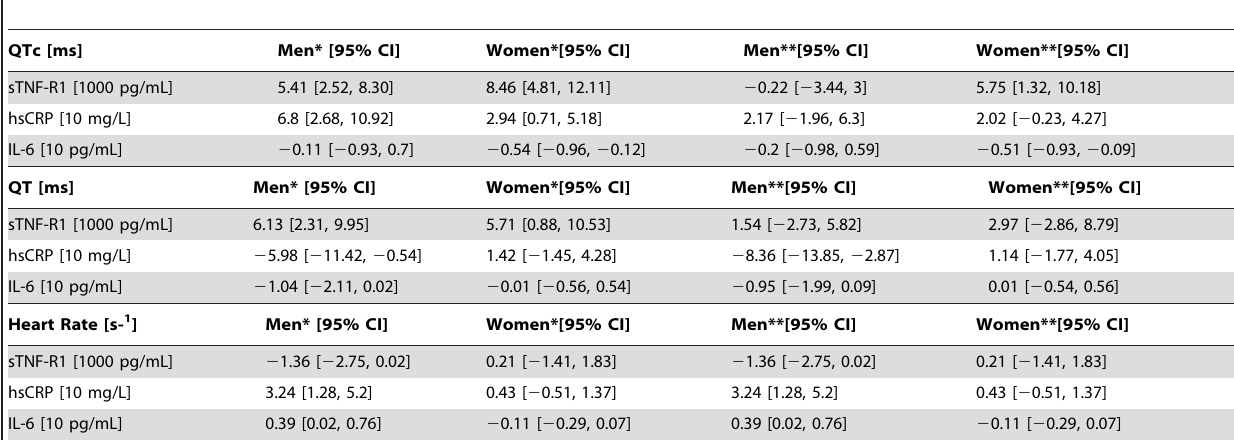
Table 2. Linear regression of QTc, QT time and heart rate (HR) on sTNF-R1 in men and women (estimates with 95% confidence